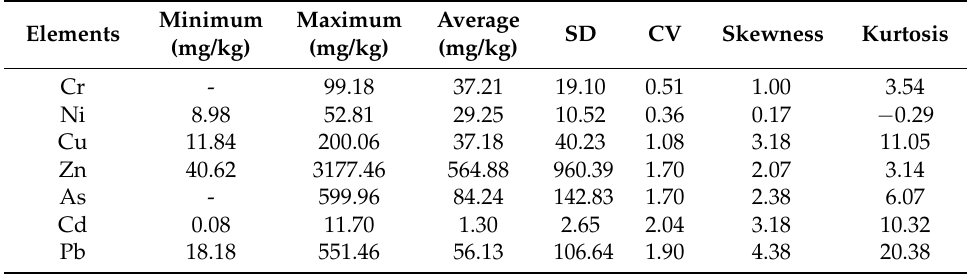
Table 5. Statistical description of arsenic and heavy metals in surface soil in the Dongshengmiao mining area (dry weight).